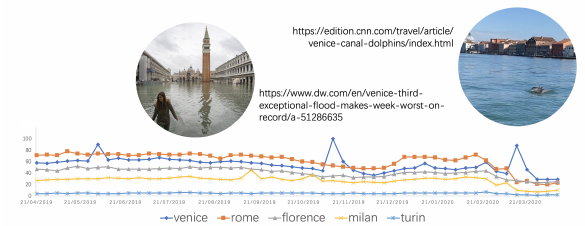
Figure 3. The relative search interest of five cities in part listed as World Heritage between April 2019 to 2020 on Google Trend search engine. The two main events happened in Venice causing discussion peaks are paired with corresponding news articles.